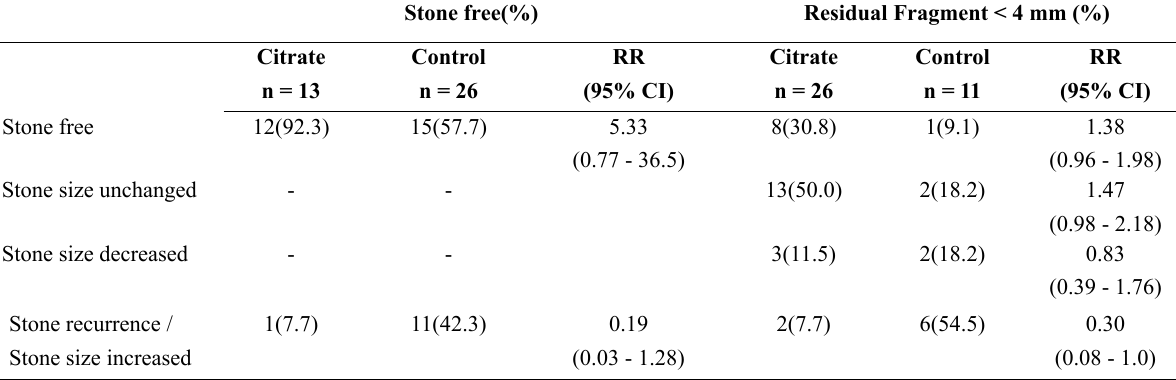
Table 3 - Stone-forming activity at 12 months (Overall n =